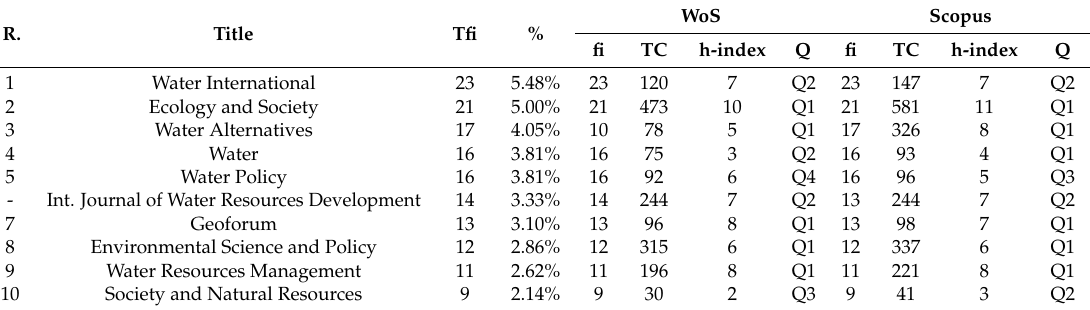
Table 5. Main Publication